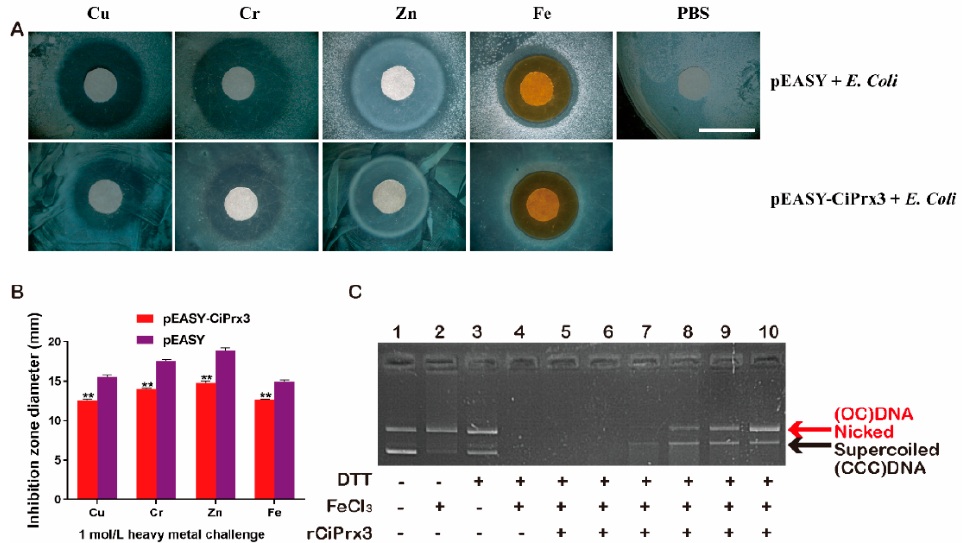
Figure 7. The heavy metal-resistant and DNA protection ability of CiPrx3. ( A ) The heavy metal- resistant ability of CiPrx3 . E. coli BL21 strains were transformed with the pEASY- CiPrx3 vector or pEASY-Blunt and then treated with different kinds of heavy metal ions. Scale bar = 1 cm. ( B ) Inhi- bition zone diameter of E. coli after heavy metal stimulation. Data were shown as the mean ± SD ( n = 3). Asterisks represent significant differences (** = p ≤ 0.01). ( C ) Determination of the DNA protec- tion ability of CiPrx3 by MFO assay; 1: pcDNA3.1 without incubation; 2: pcDNA3.1 + FeCl 3 (10 μ M);